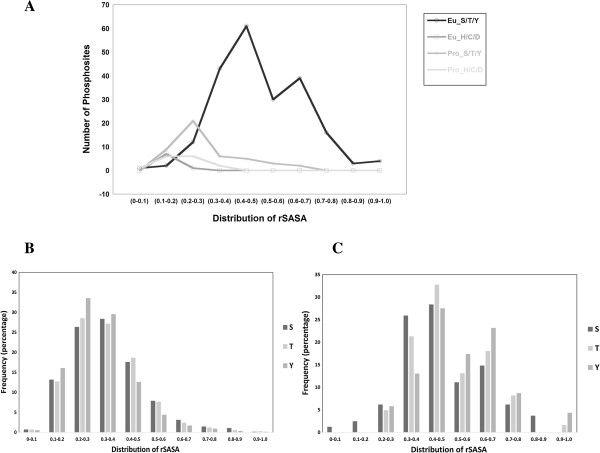
Conformational map of the phosphoproteome. A) Phosphorylated proteins in the PDB data set were classified under eukaryotes and prokaryotes. These were further subdivided in to subsets of conventional (Eu_S/T/Y, Pro_S/T/Y) and unconventional (Eu_H/C/D, Pro_H/C/D) phosphorylation sites. All subsets were binned with size interval of 0.1. Majority of eukaryotic conventional phosphorylation sites registered rSASA values >0.2. The rSASA values were also calculated for the single residues Ser, Thr and Tyr from phosphosite data B) and from the PDB data C).